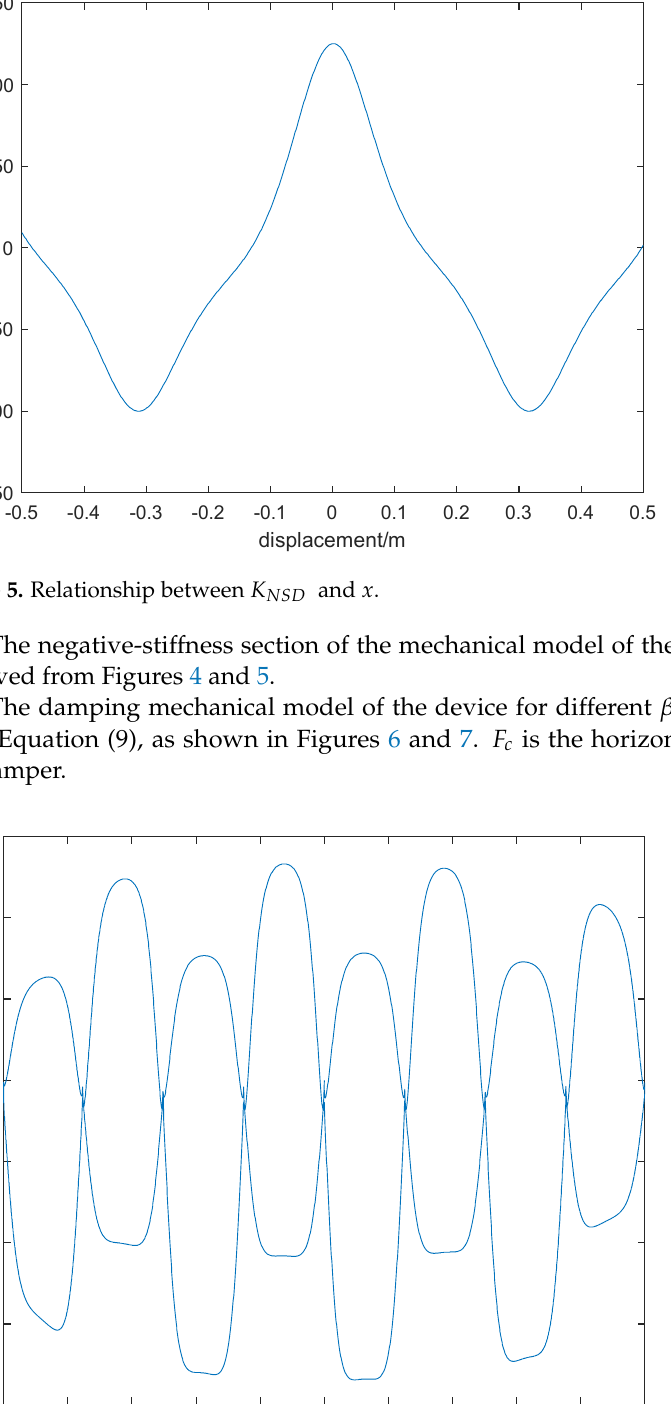
Figure 4. Mechanical model of negative−stiffness device.